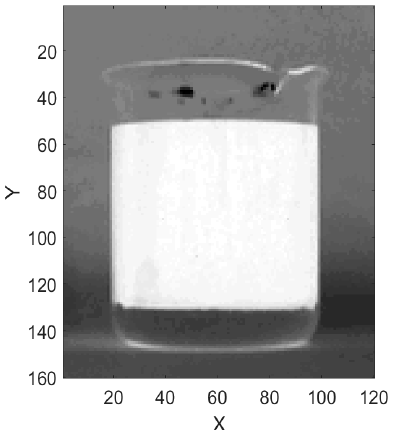
Figure 3. Grayscale image of crude oil to be tested.